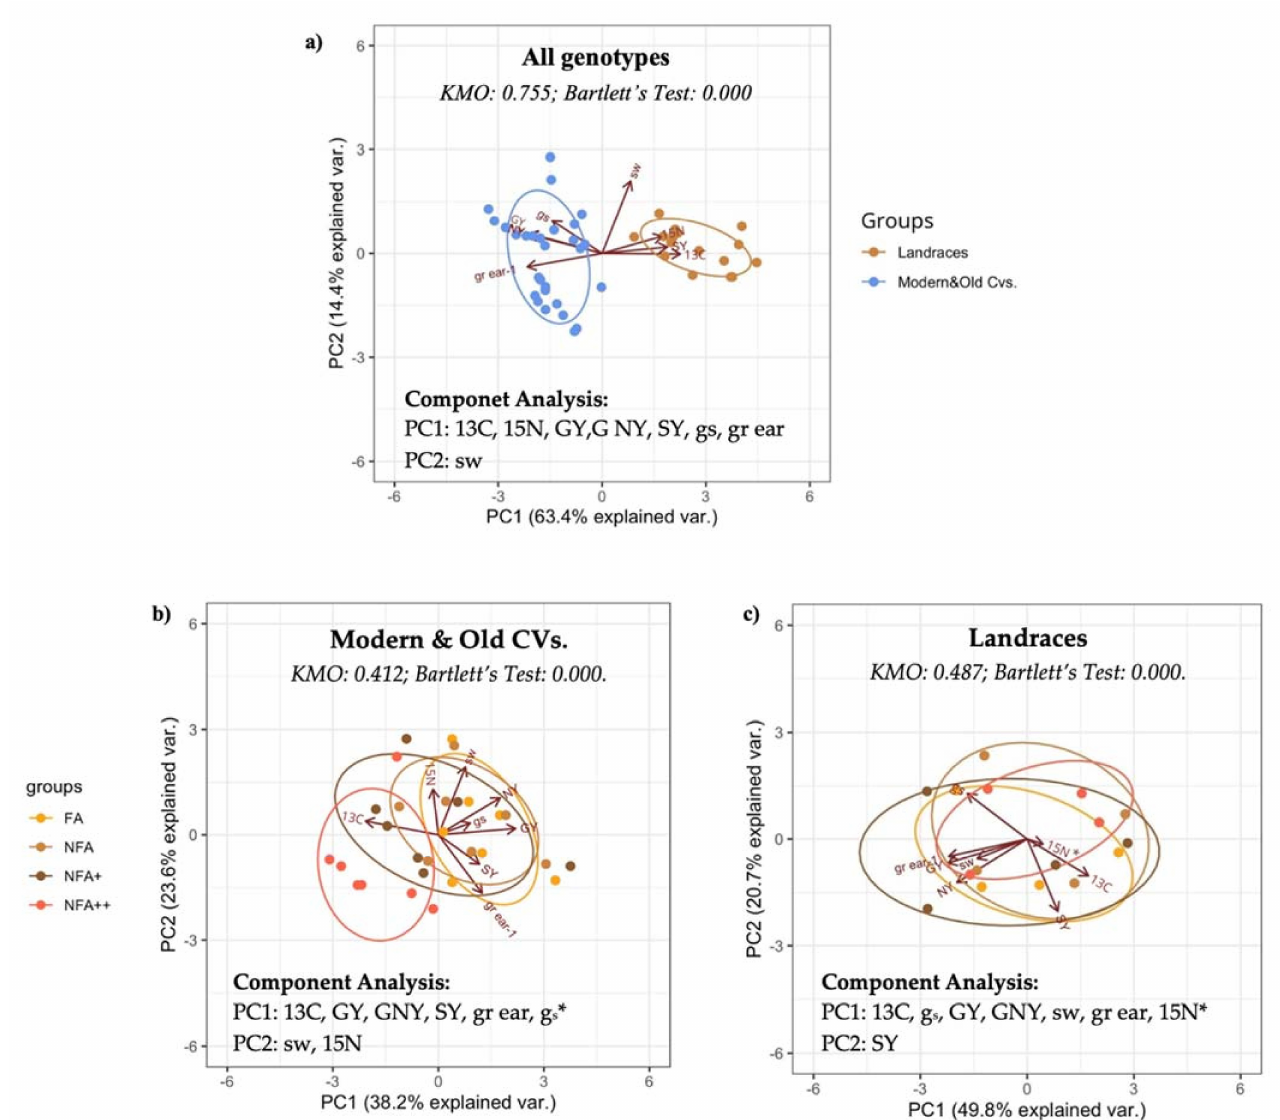
Figure 6. Principal Component Analysis for: ( a ) each age-type genotype based on standardized values of 13C, δ 13 C grain (‰); 15N, δ 15 N grain (‰); GY, grain yield (g pot − 1 ); GNY, grain N yield (g N pot − 1 ); SY, straw yield (g pot − 1 ); sw, single seed weight (mg); g s , stomatal conductance (mmol H 2 O m − 2 s − 1 ); and gr ear − 1 , grains per ear, for eleven (exc. Pane 247) Mediterranean wheat genotypes, ( b ) Modern & Old CVs and ( c ) Landraces separated by ozone treatment. * Low Component Matrix